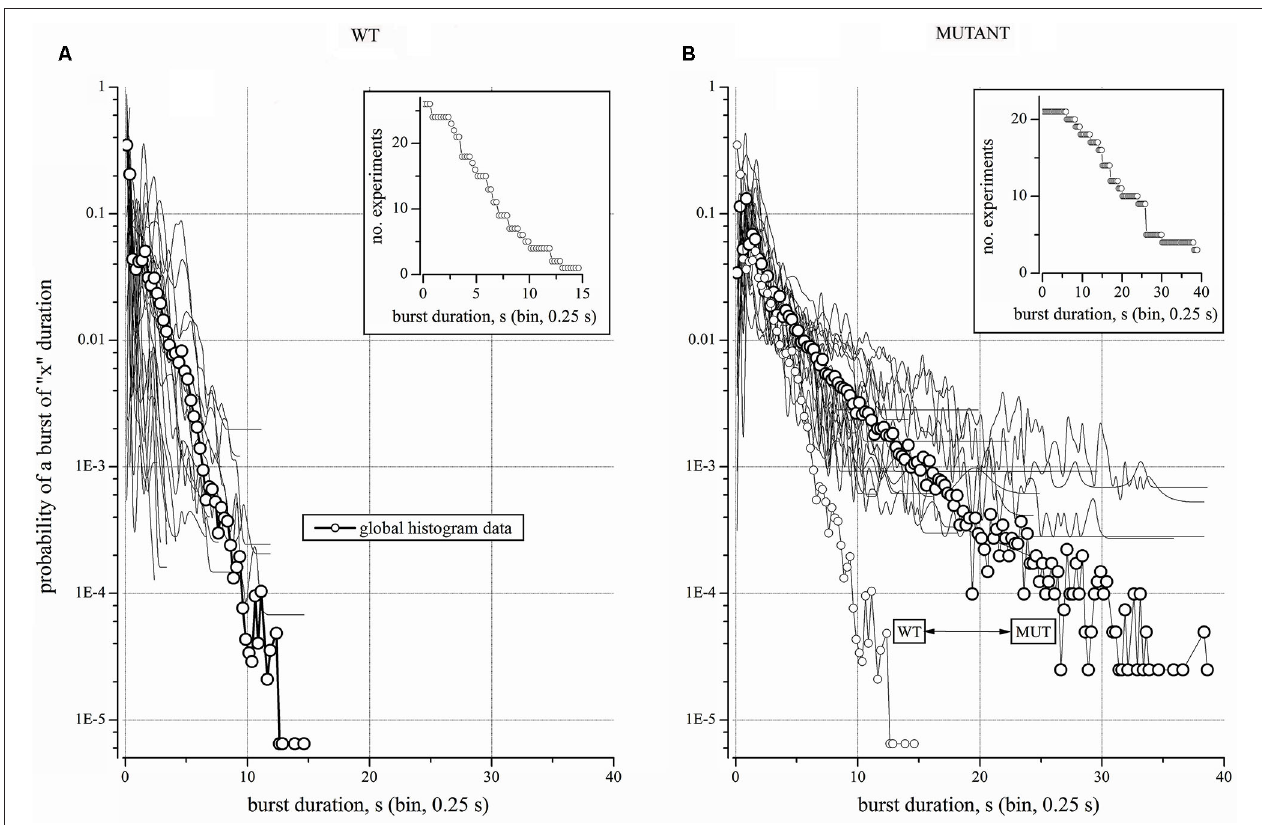
considered in (A) . (B) Mutant. Log-scale plot of the average probability of finding a burst of “x” duration in 21 experiments (line + open circles). To illustrate the heterogeneity of networks, the 21 single-experiment plots are superimposed as thin lines (points are connected by B-Spline). Inset: distribution of the BD for the experiments that were considered in (B)